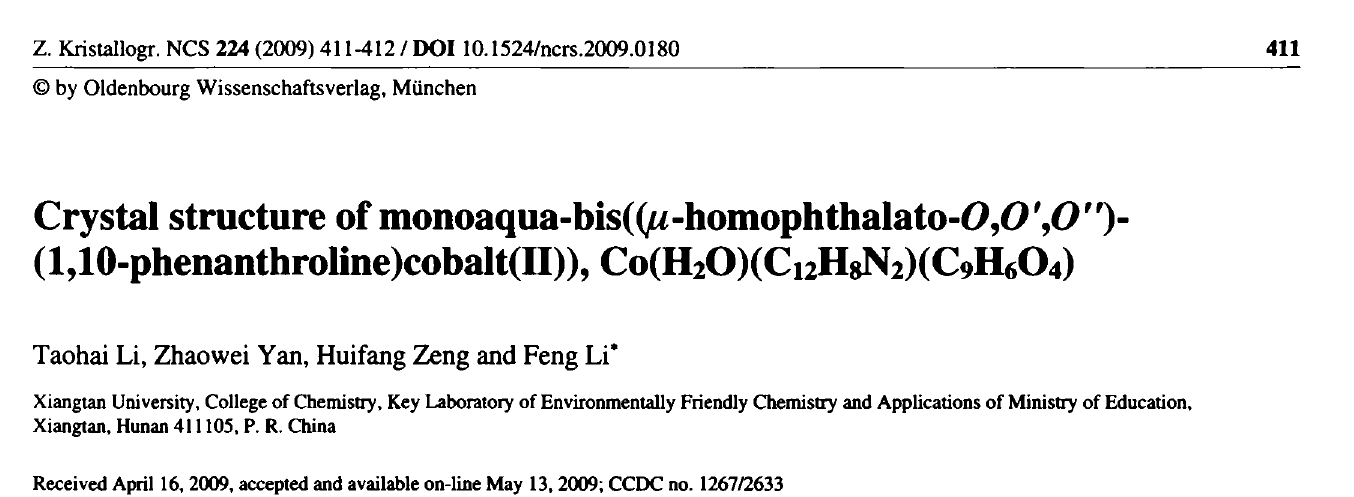
C42H32C02N4O10, monoclinic, P12i/cl (no. 14), a = 8.8186(6) Â, b = 19.199(1) À,c= 13.0989(8) Â, β = 123.070(4)°, V= 1858.5 Â 3 , Z= 2, R gl (F) = 0.037, wRretfF 2 ) = 0.092, T= 173 K.